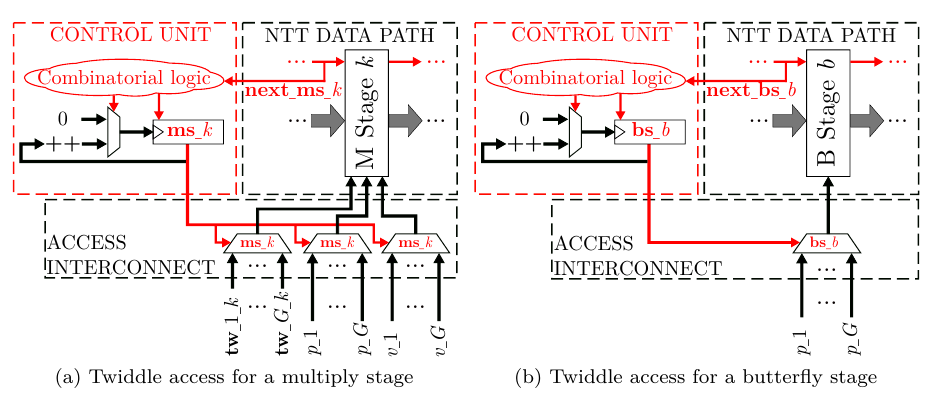
Figure 4: Control of the twiddle access to feed NTT data path. Schematics for w = 2.